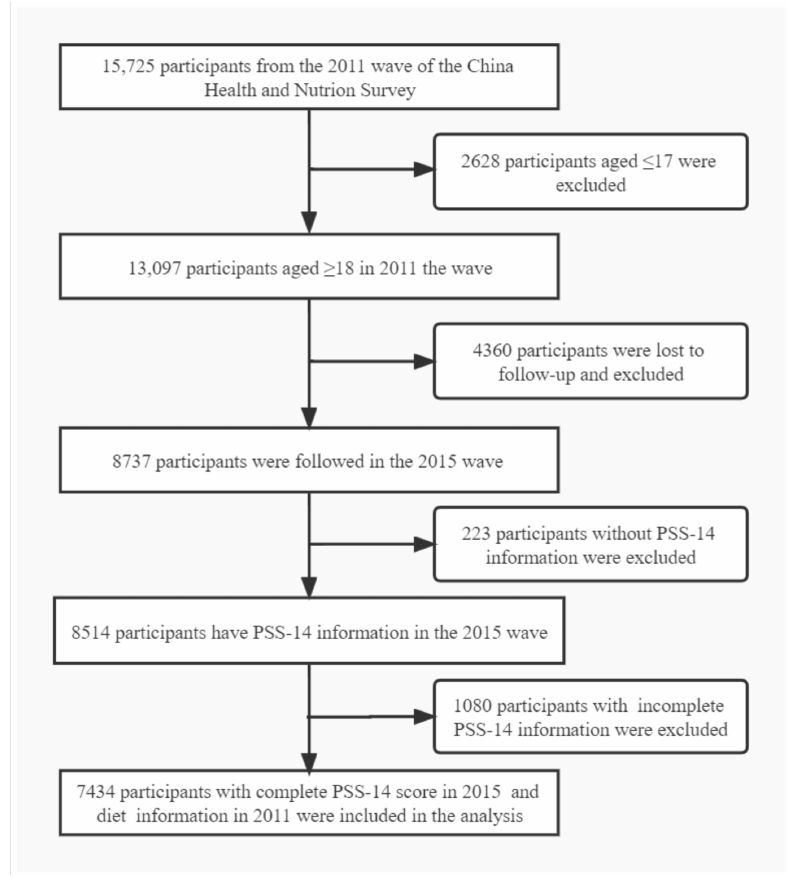
Figure 1. Participant flow